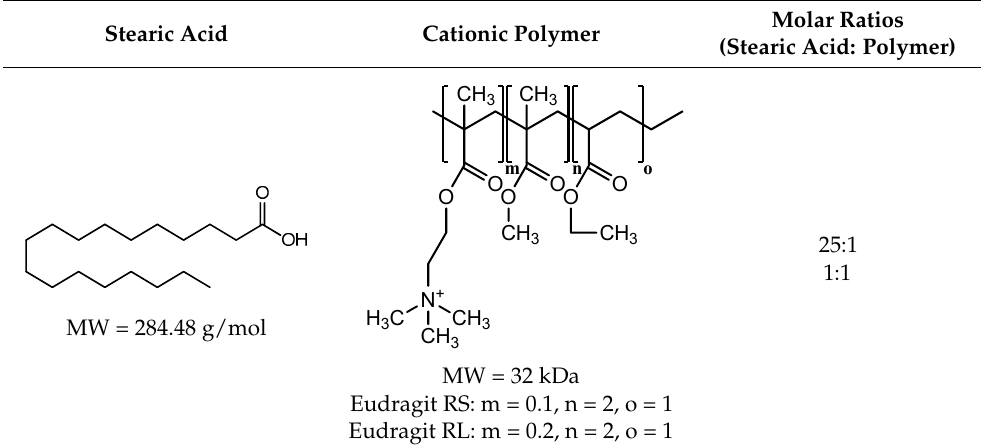
Molar Ratios Molar Ratios (Stearic Acid: Polymer)